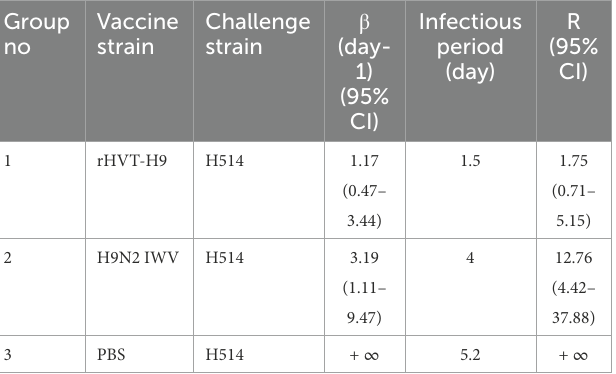
TABLE 5 Transmission rate parameters in different groups. Group Vaccine Challenge no strain